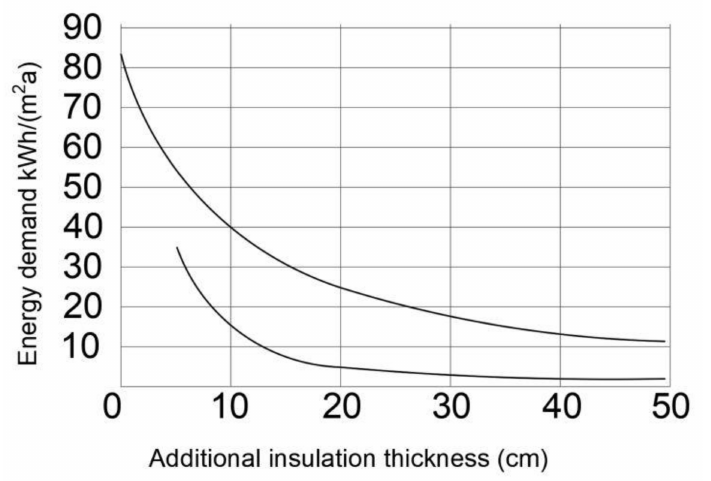
Figure 1. Comparison of additional insulation thickness and energy demand. Reproduced with permission from